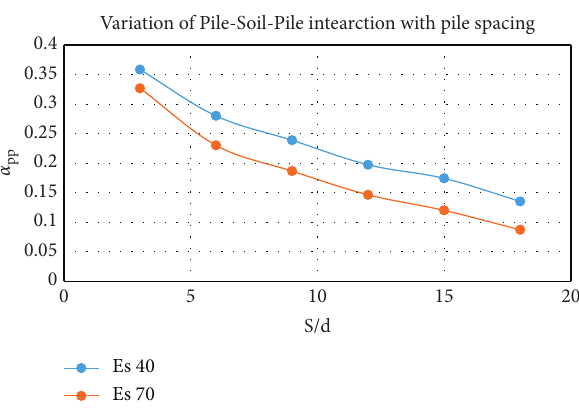
Figure 11: Pile-soil-pile interaction vs. S / d . Table 8: Parameters selected for finding an effect of interaction